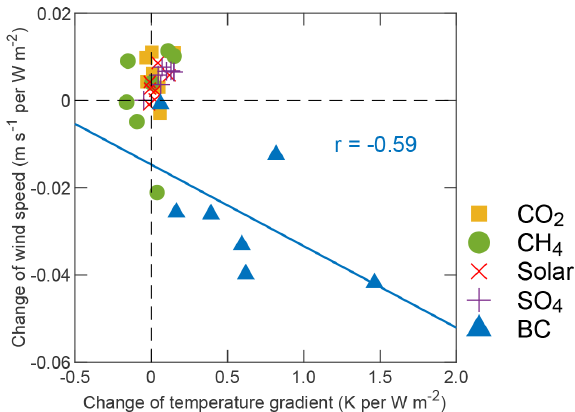
Figure 8. Changes of wind speed versus changes of temperature gradient for each individual model and simulation. The CESM1- CAM4 model is excluded due to the unavailability of surface wind data. The linear correlation r is for the BC